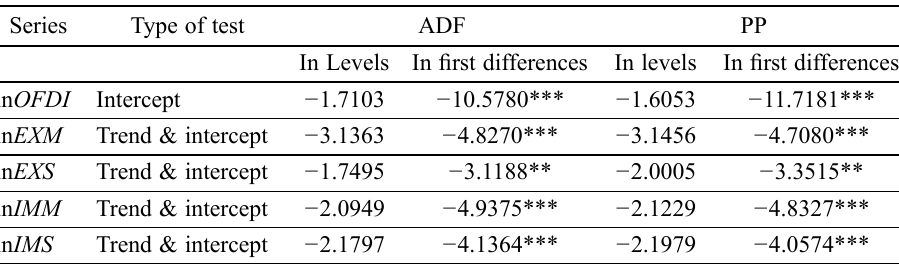
Table 8. Unit root test results